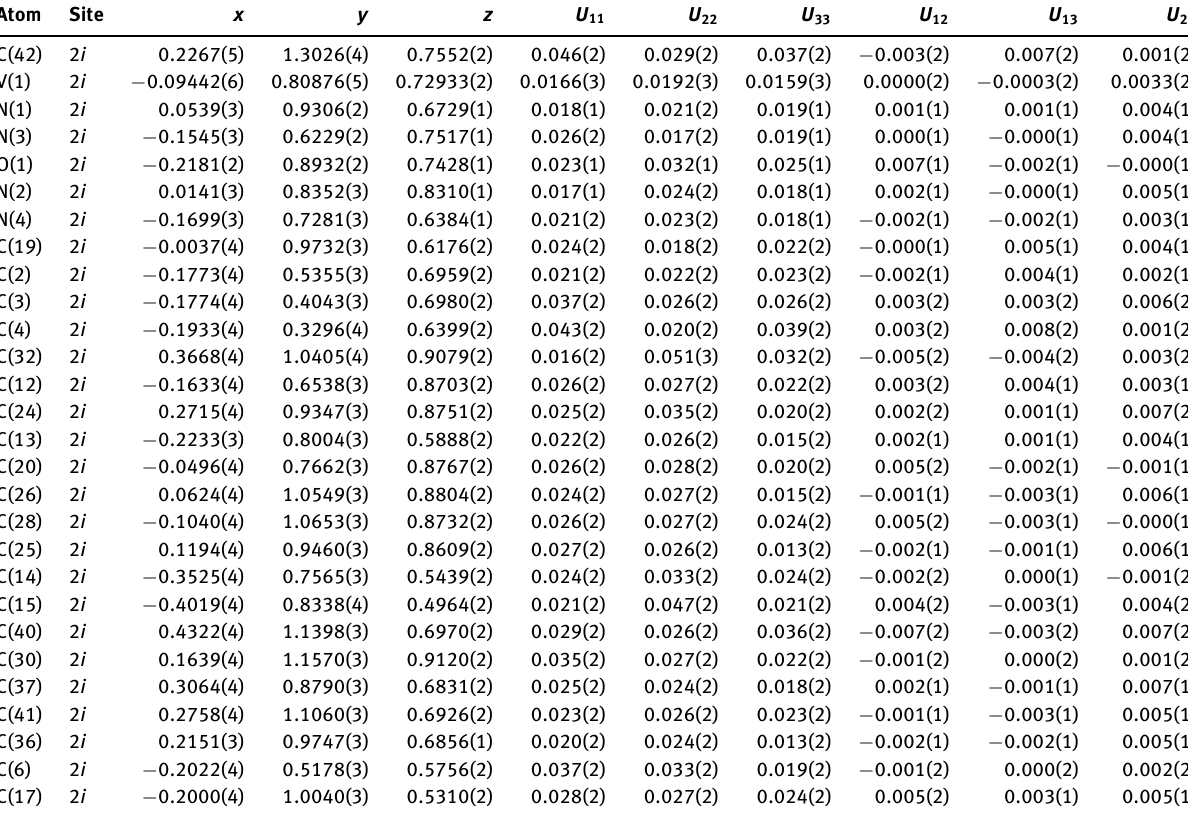
Table 3: Fractional coordinates and atomic displacement parameters (Å 2